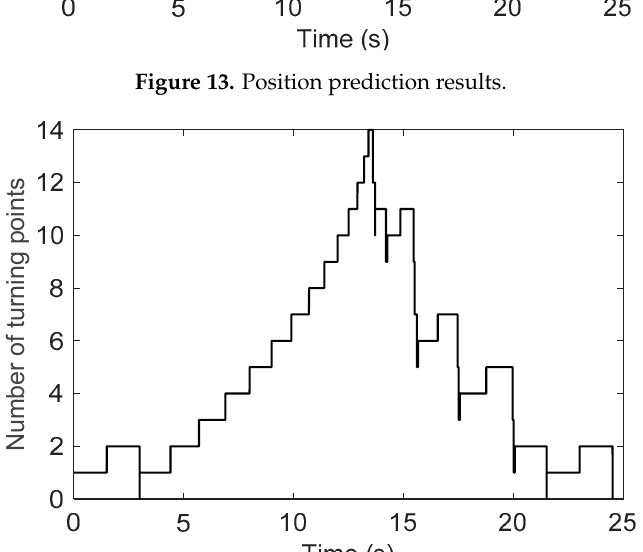
Figure 14. Number of turning points varying with time.